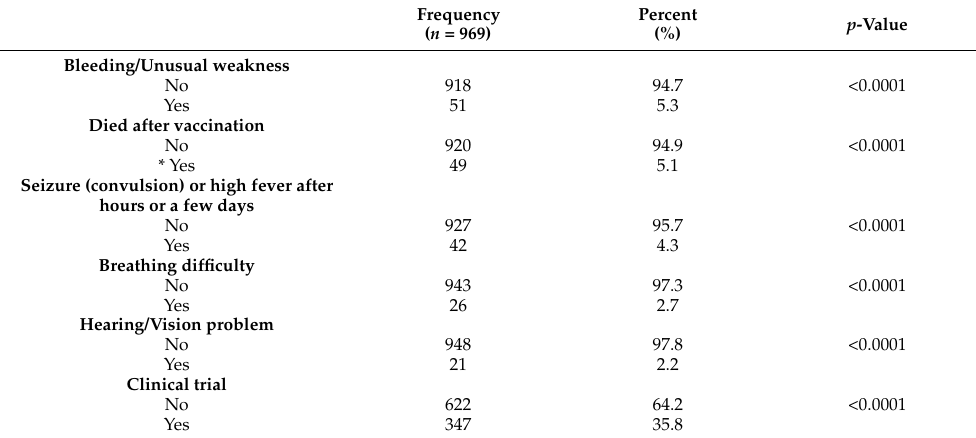
Table 6. Rare and fatal cases following COVID-19 vaccination among Africans.